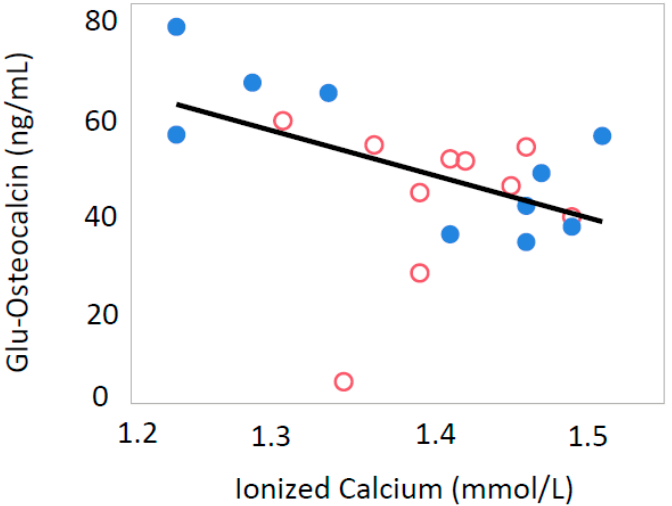
Figure 2. Relationship between ionized calcium and Glu-osteocalcin levels in all male rat offspring (R = − 0.359, p = 0.0154). Open circle; male offspring from control group, closed circle; male offspring from Ca-deficient group. Open circle, male offspring from control group; closed circle, male offspring from Ca-deficient group.